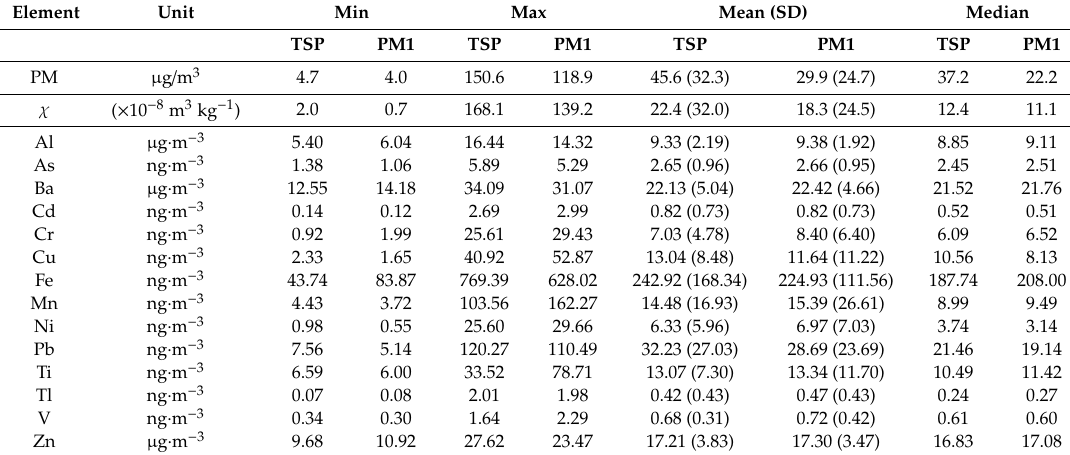
Table 3. Descriptive statistics of magnetic susceptibility ( χ ) and concentration of PM (PM) and potentially toxic elements (n TSP = 35; n PM1 = 35).